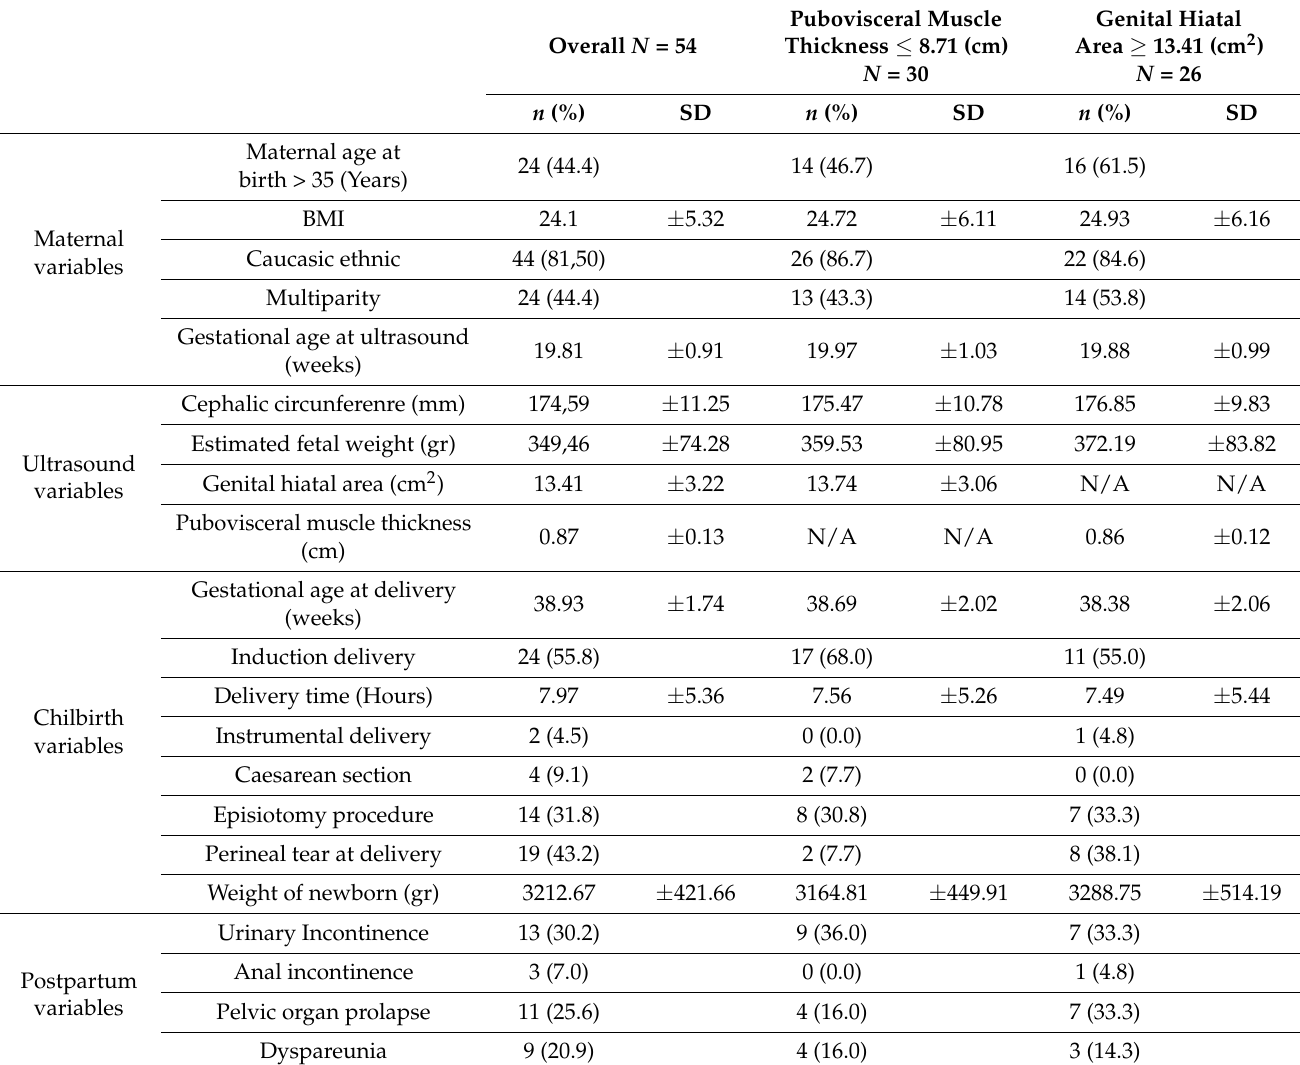
Table 1. Characteristics of the study population. N values differ inside groups because of missing data of patients without childbirth variables and postpartum variables ( N =